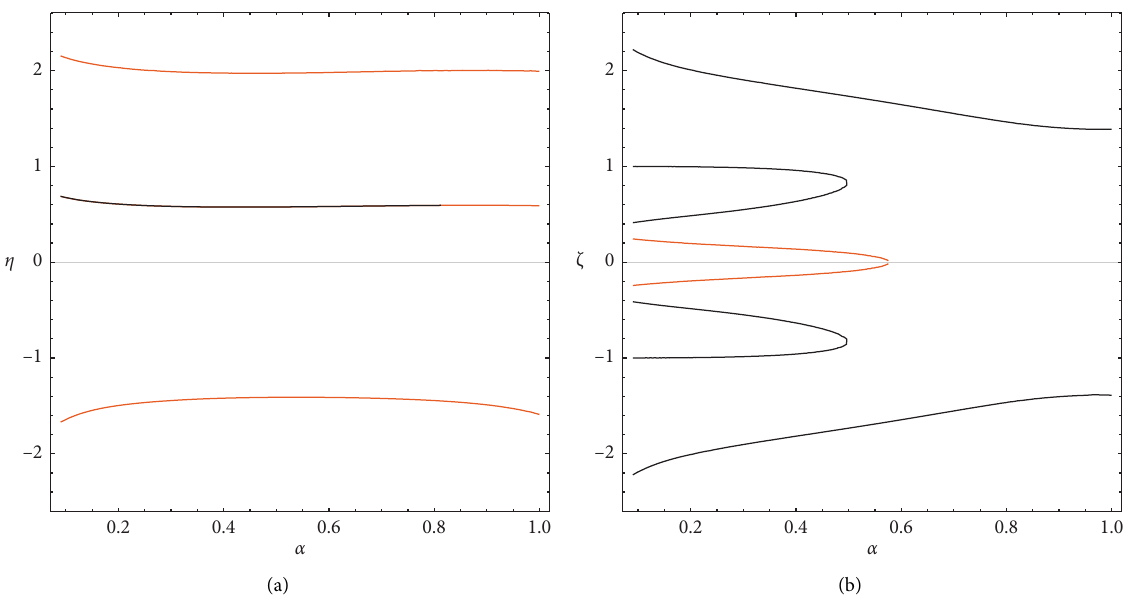
Figure 14: (a) Equilibrium solutions on η − axis when m solutions which are inside the kite. (b) Φ